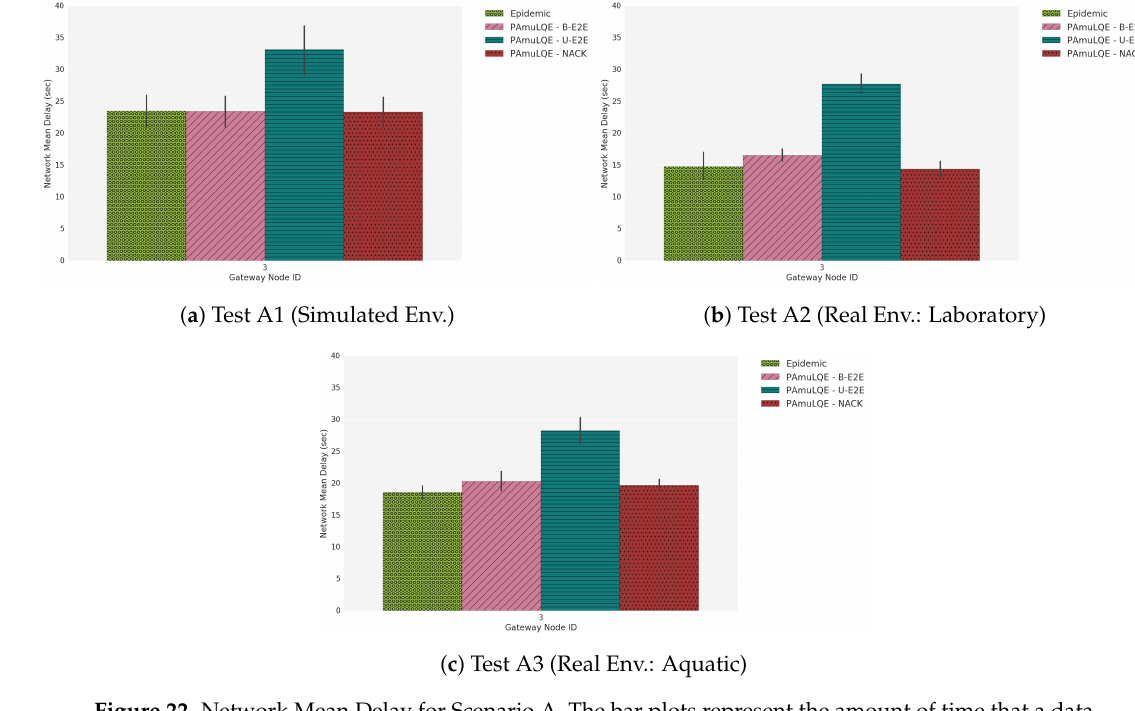
Figure 22. Network Mean Delay for Scenario A. The bar plots represent the amount of time that a data packet takes since its generation until it reaches a gateway.